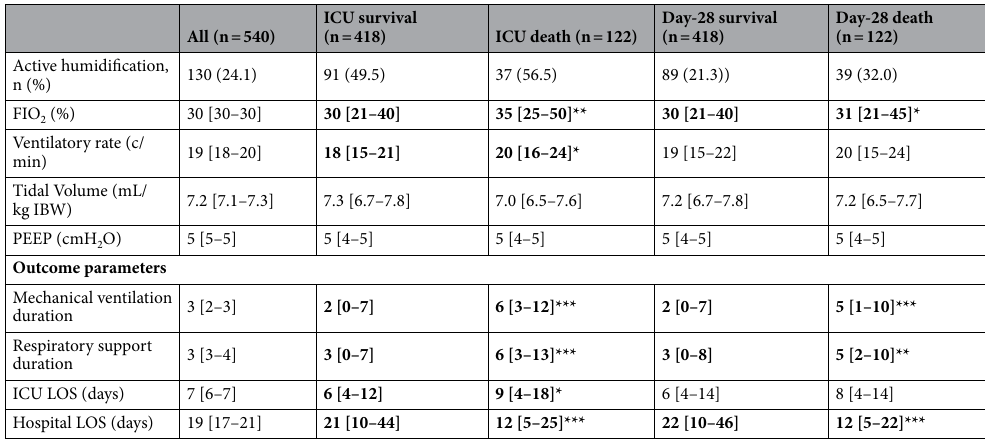
Table 1. Comparison between physiological characteristics, according to ICU and Day-28 mortality. Results are provided as Median [95% CI for the Median], or Number (%), unless specified otherwise. For the head of columns, the number of patients in between parenthesis represent the number of patients for whom the parameter was available for monitoring. Unstable hemodynamics was defined as the need for > 1 L fluid expansion and/or vasopressive agents introduction/posology modification within the previous 24-h; Patient/Ventilator Asynchrony was detected at the patient’s bedside during data monitoring and considered if the Asynchrony Index was higher than 10%; Respiratory support was defined as either the use of invasive mechanical ventilation, noninvasive ventilation and high nasal flow oxygen therapy. BMI body mass index, Day 28 mortality was assessed at day 28, ECMO extracorporeal membrane oxygenation, FIO 2 inspired oxygen fraction, LOS length of stay, SAPS II simplified acute physiological score II, SpO 2 pulse oximetry, ICU intensive care unit. Significant values are in bold.